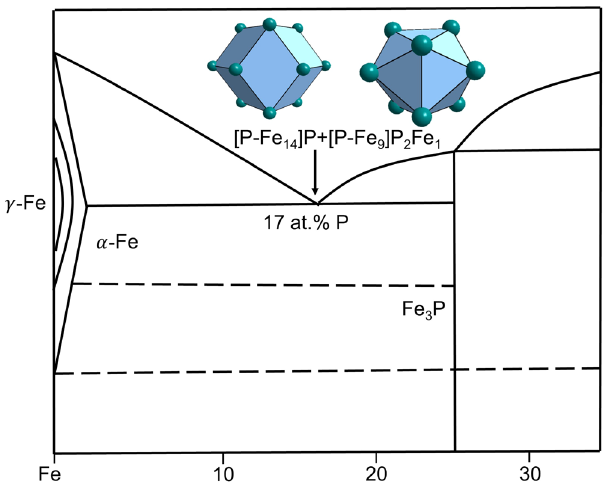
Figure 5. Interpretation of eutectic point Fe 83 P 17 by the dual-cluster formula [P-Fe 14 ]P + [P-Fe 9 ]P 2 Fe derived from eutectic phases α -Fe and Fe 3 P (Ni 3 P).